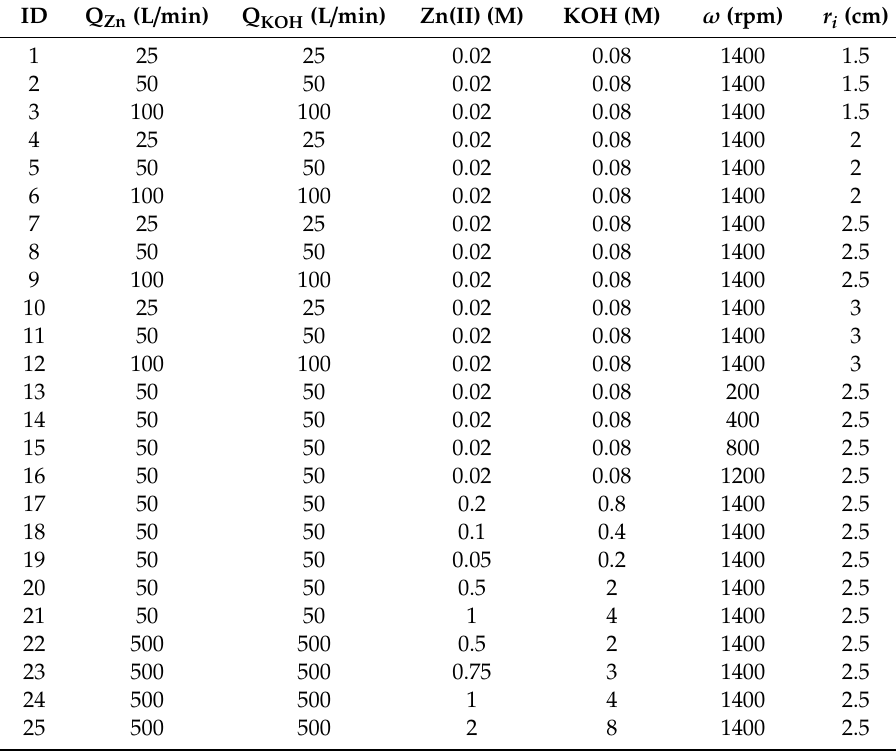
Table 1. Experimental conditions adopted in the 25 runs.